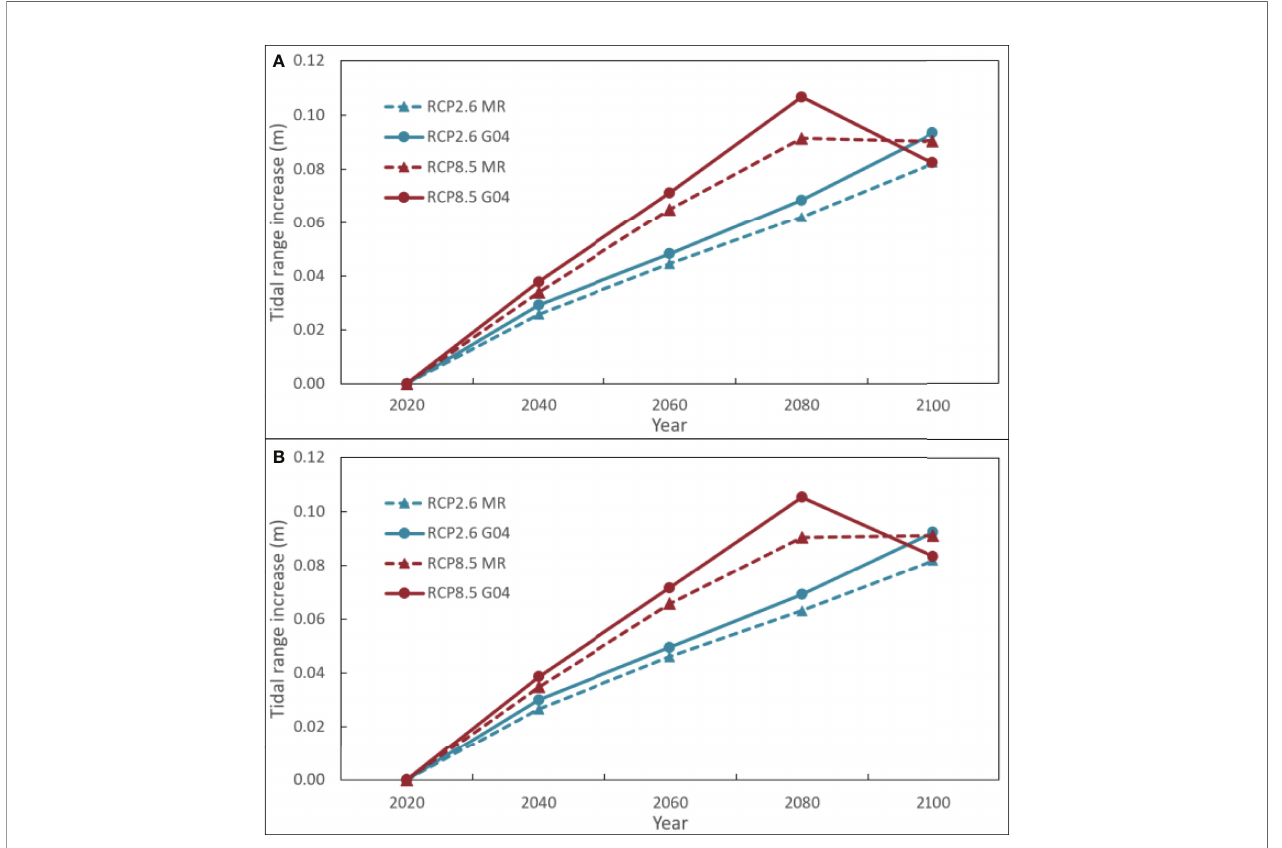
FIGURE 8 | Increases in spring tidal range under low (blue) and high SLR (red) for an upstream (G04 – solid lines) and downstream location (MR – dashed lines), as well as WEM Linear 1 (panel A ) and Linear 2 (panel B ). See Figure 3 for the exact location of both monitoring sites. Values are with respect to maximum spring tidal range modelled for